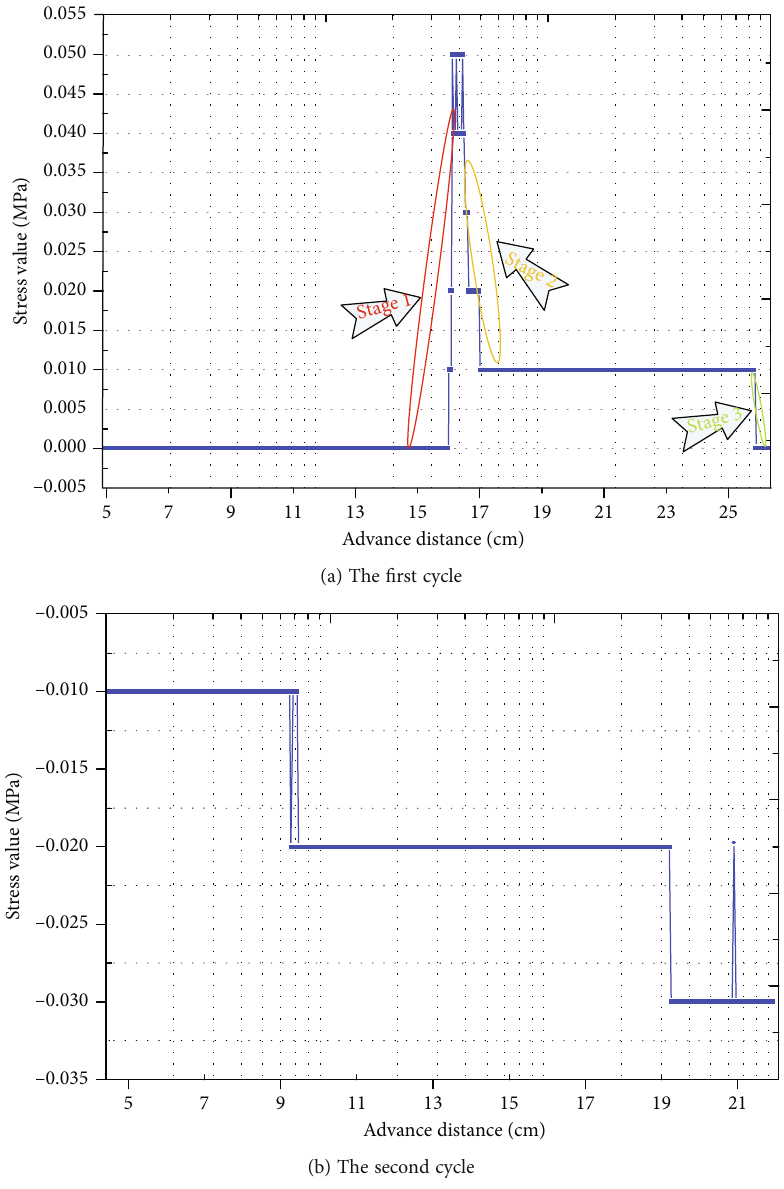
Figure 16: Stress at monitoring point S1-3 vs. the distance